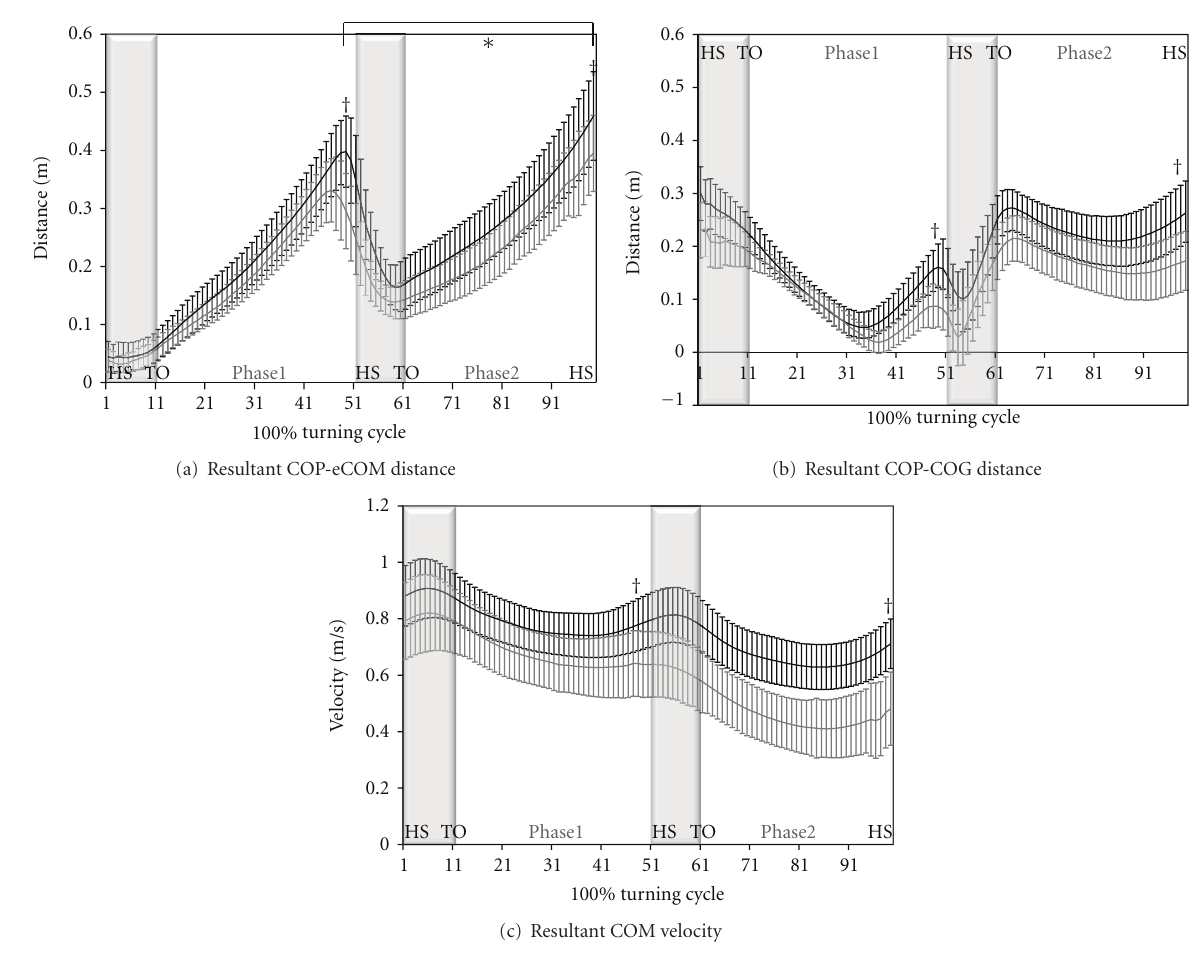
Figure 3: Resultant COP-eCOM distance (a), and resultant COP-COG distance (b), resultant COM velocity (c) between groups during the step turn cycle ( ± sd). HS: heel strike; TO: toe o ff ; light gray line: persons with early-stage Parkinson’s disease; black line: healthy control participants; gray shadow: double limb support time; white shadow: single limb support time. † denotes statistically significant di ff erence between groups ( P < 0 . 05). ∗ denotes statistically significant di ff erence between phases ( P < 0 .